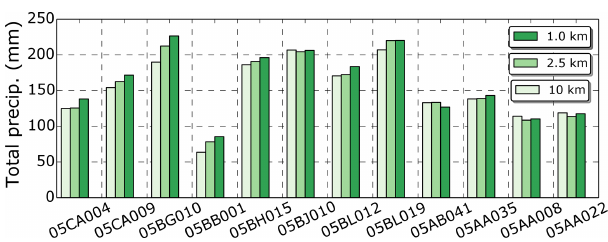
Figure 7a and b compare simulated initial SWE